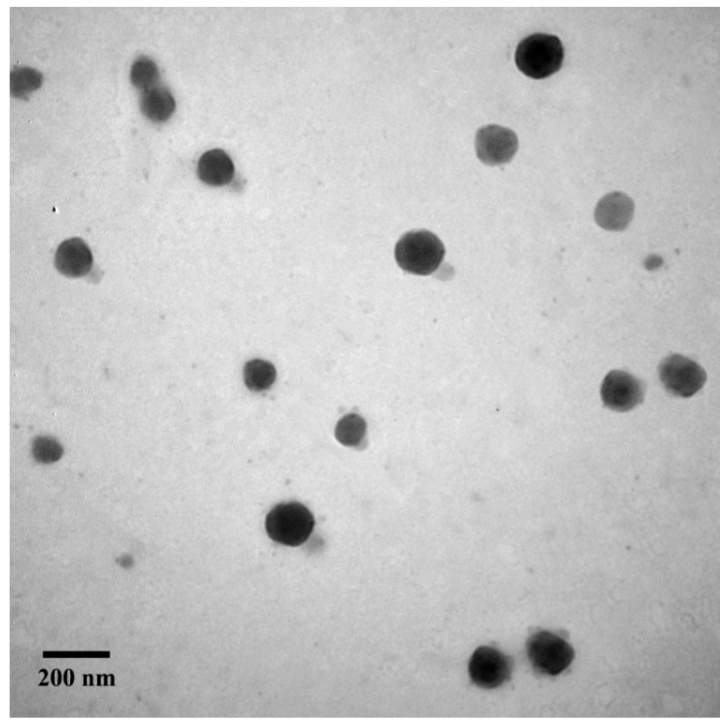
Figure 2. TEM image of